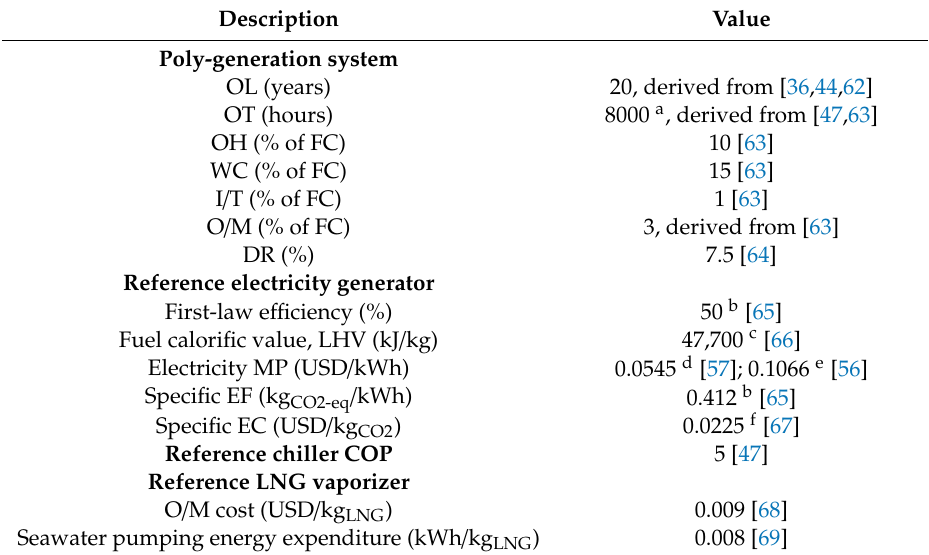
Table 7. Monetary and environmental input modeling data for the poly-generation